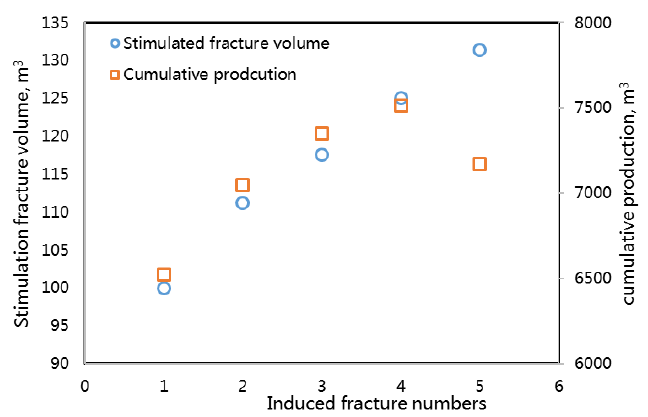
Figure 8. Stimulated fracture volume and cumulative oil production change with respect to induced fracture